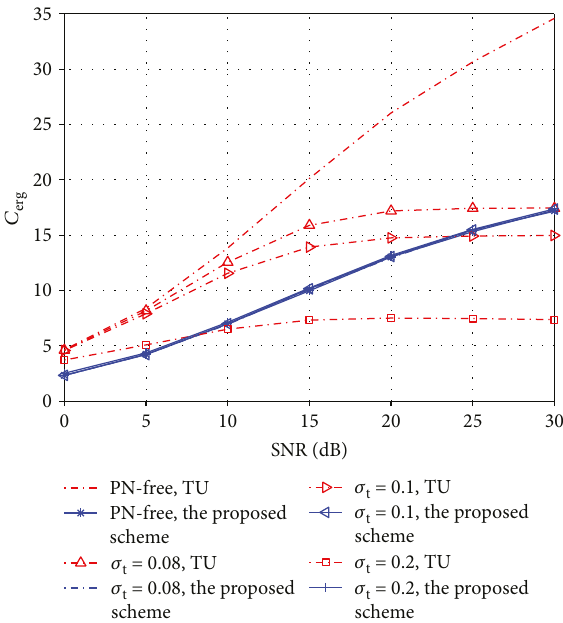
Figure 8: The ergodic capacity comparison between the proposed scheme and TU scheme for the massive MIMO-OFDM uplink system. χ = 1 = σ . r t